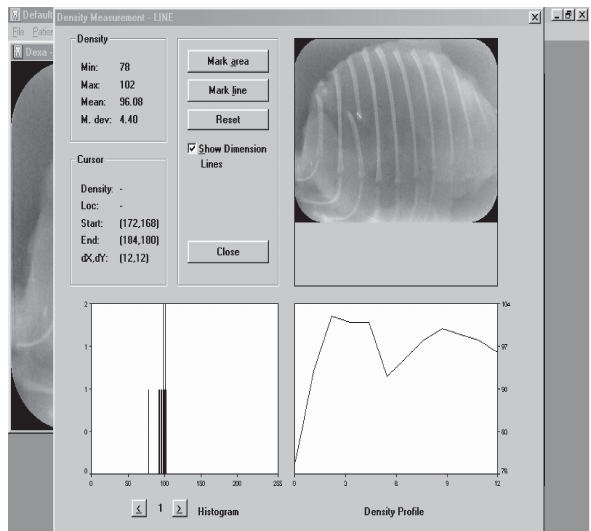
FIGURE 1 - Image showing Bone Linear Density analysis by Digora System determining the line over the fracture stubs (arrow), showing the minimum (78.00), maximum (102.00), and the mean (96.80) density profiles for this image